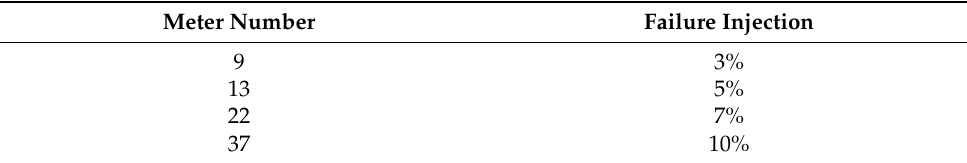
Table 4. Fault injection